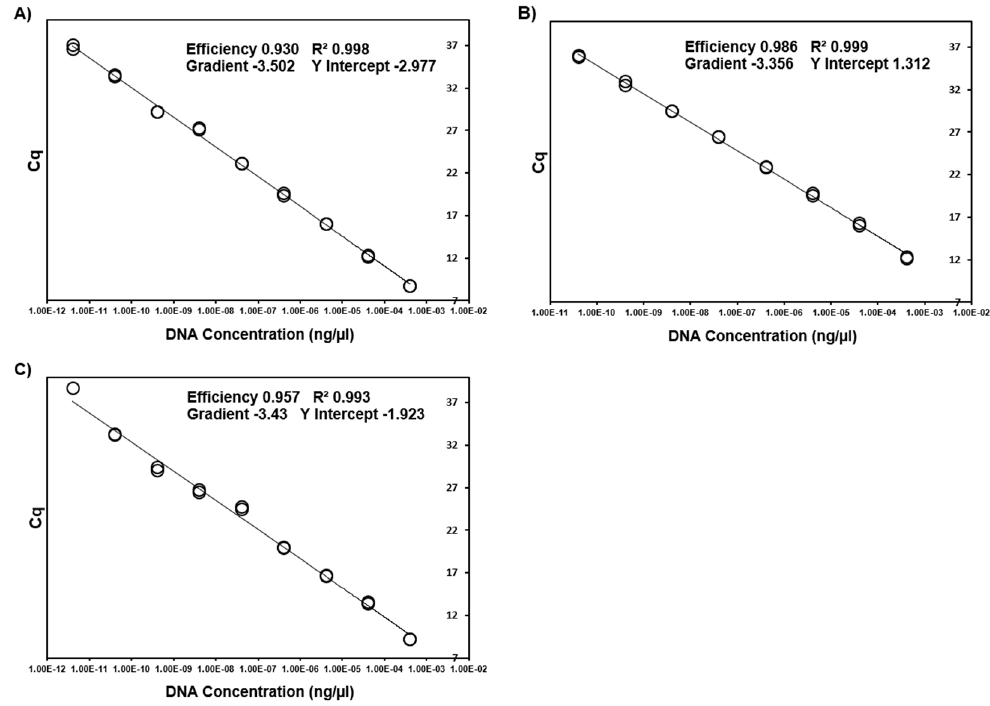
Figure 1. Standard curves generated from 12-fold serial dilutions of target gBlock Gene Fragments from the apicomplexans; B. vogeli ( A ), B. gibsoni ( B ) and H. canis ( C ).